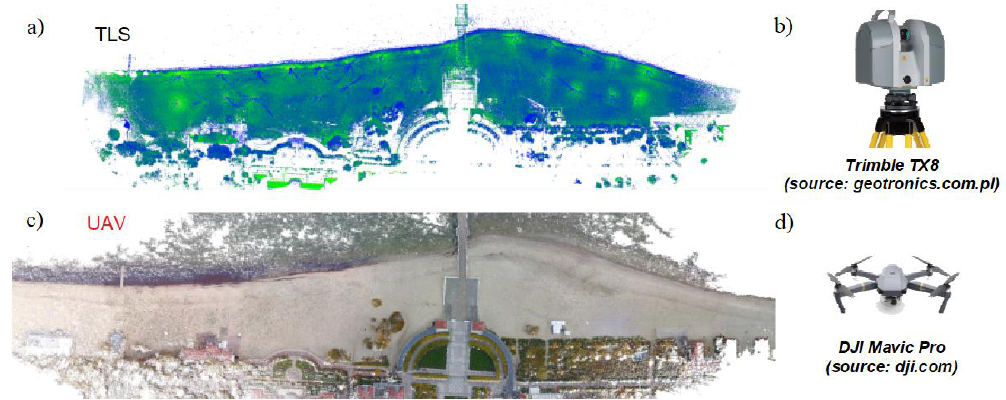
Figure 5. TLS and unmanned aerial vehicles (UAV) methods: a) and c)—point clouds originating from the measurement using two methods, b) and d)—sensing devices, respectively, to TLS and UAV methods.